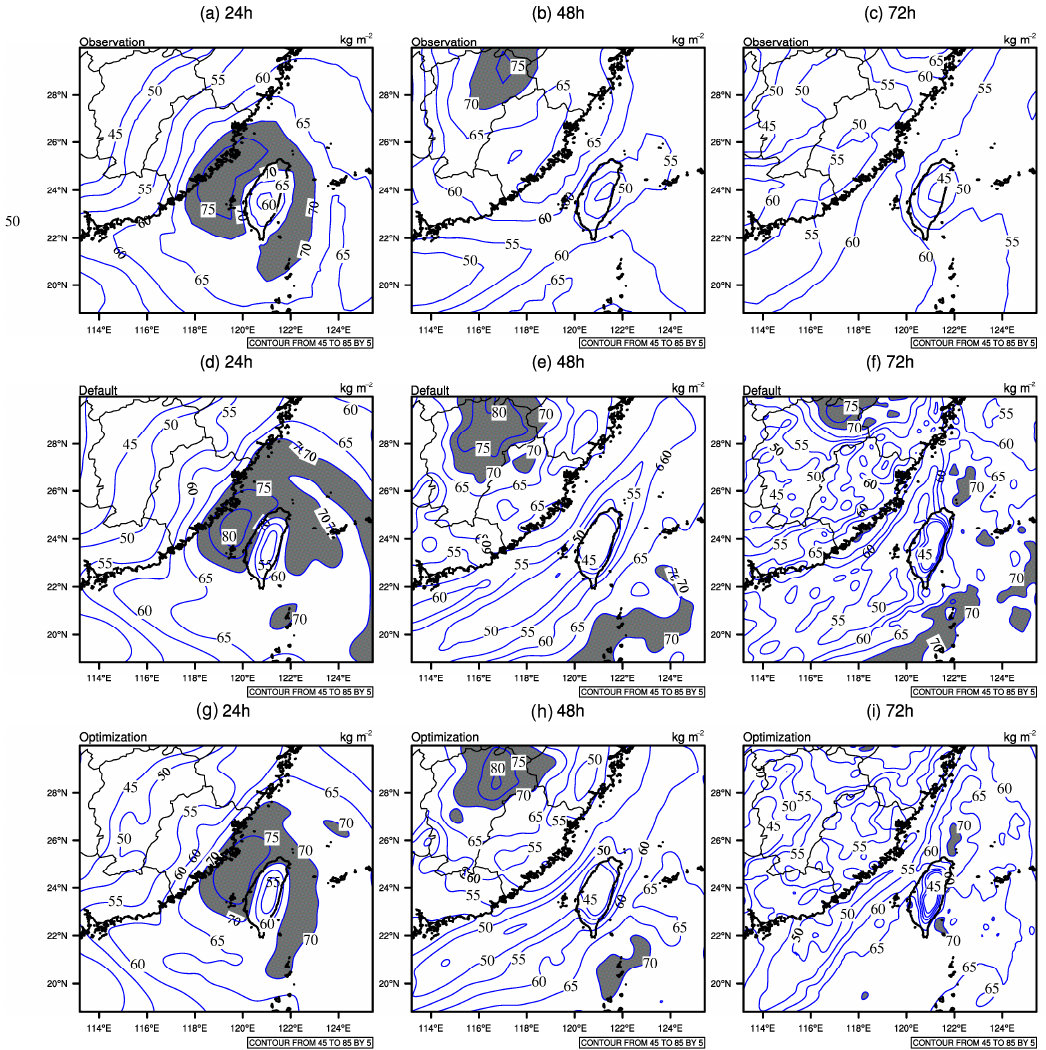
Figure 12. Same as in Figure 11, except using event (5), where the shaded areas represent values higher than 70 kg m − 2 . ( a )–( c ) represent the observed precipitable water at 24, 48, and 72 h lead times respectively; ( d )–( f ) represent the simulated precipitable water with default parameters at 24, 48, and 72 h lead times respectively; ( g )–( i ) represent the simulated precipitable water with optimal parameters at 24, 48, and 72 h lead times respectively.